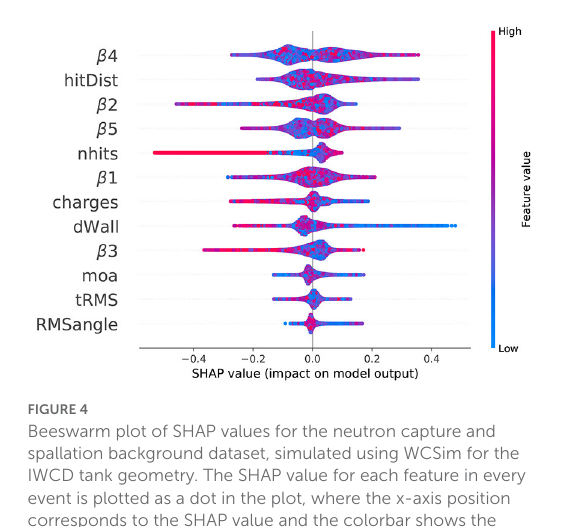
FIGURE4 Beeswarm plot of SHAP values for the neutron capture and spallation background dataset, simulated using WCSim for the IWCD tank geometry. The SHAP value for each feature in every event is plotted as a dot in the plot, where the x-axis position corresponds to the SHAP value and the colorbar shows the feature value (blue is low, red is high). High SHAP values influence the model output toward 1 (electron-like event) and low SHAP values (negative) influence the model outputs toward 0 (neutron-like